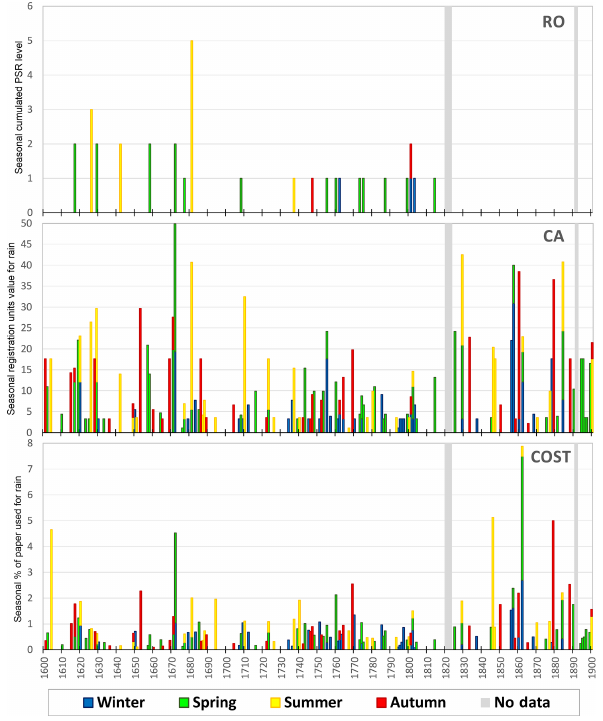
Figure 8. Seasonal extreme rainfall in Caravaca between 1600 and 1900. Seasonal values accumulate for each year. In this way, the an- nual value is defined as the sum of the four seasonal values for a given year. The values on the y axis are in the unit that corresponds to each methodology, i.e. the sum of the pro serenitate rogation lev- els for each station in RO, the sum of the values of RU for drought in CA and the percentage of paper used for drought during each season in COST. Note: data gaps (from 1820 to 1823 and 1891 to 1892) are shown in grey.